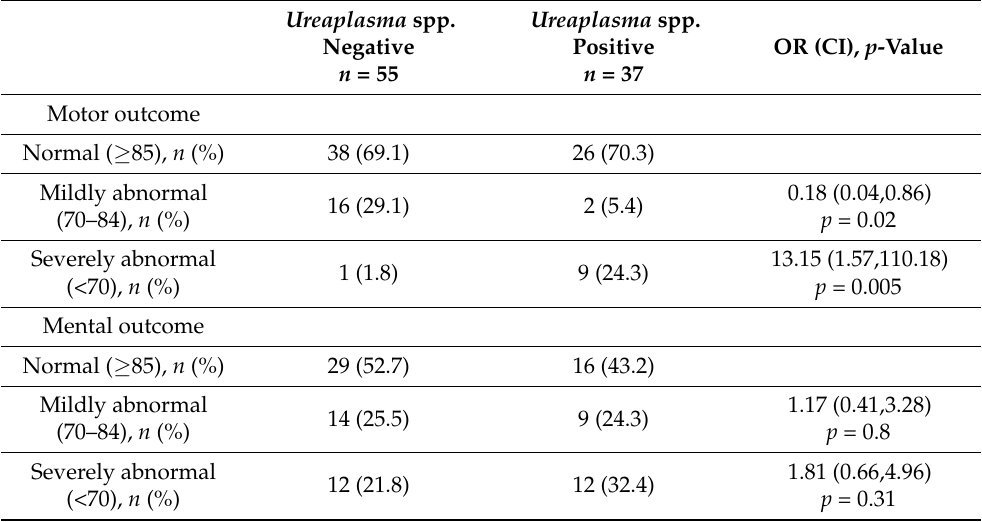
Table 3. Neurodevelopmental outcome at 24 months adjusted age in relation to vaginal Ureaplasma spp. colonization status of the mother. Odds ratios apply to comparison with infants with normal scores as reference group. Motor outcome represented as Bayley Mental Development Index Scores, Mental outcome represented as Bayley Psychomotor Development Index scores. Ureaplasma spp. Ureaplasma